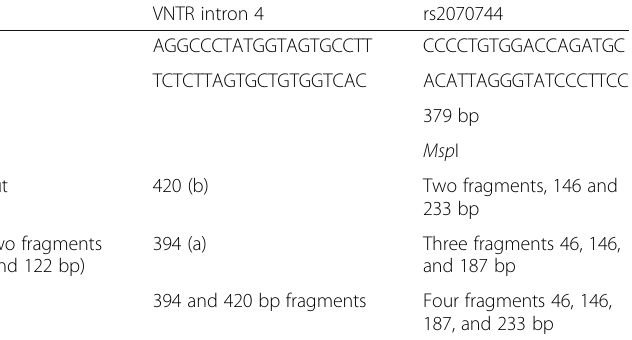
Table 1 Primers, restriction enzymes, and fragment lengths of the major and minor alleles of rs1799983, rs2070744, and